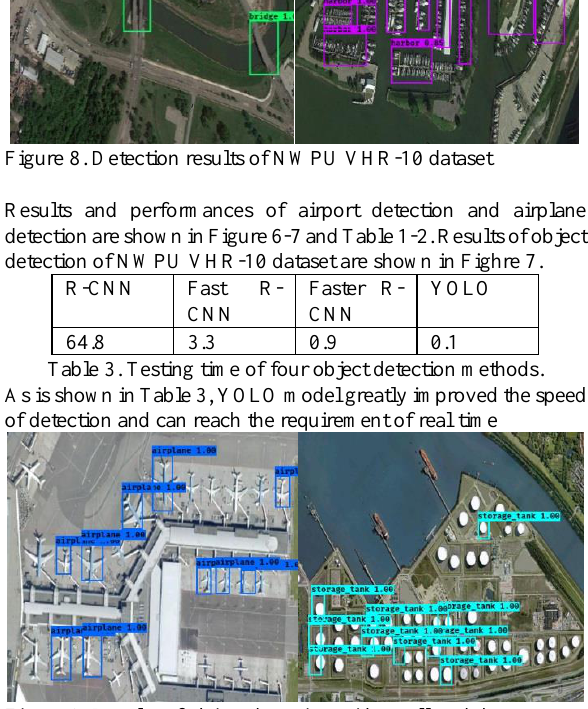
Figure 9. Results of object detection with small and dense